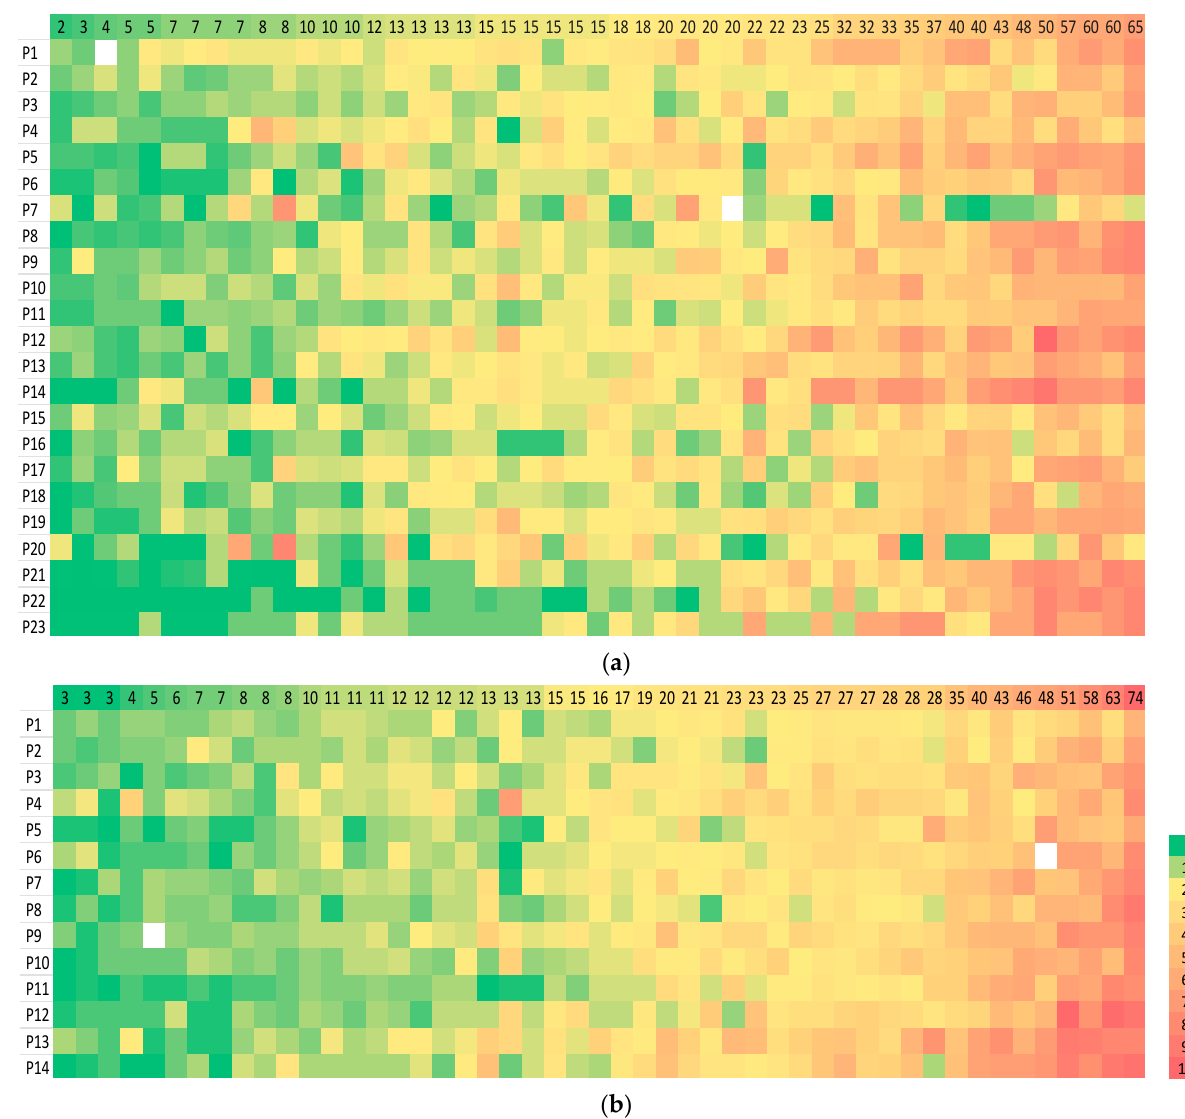
Figure 2. Heatmap of sTILs scores given by pathologists for 49 TNBC cases. A visual representation of sTILs scores in which each row represents a pathologist (numbered as in Figure 1) and each column a case for ( a ) Circulation 1 and ( b ) Circulation 2. The colour of each cell represents the sTILs score for the case, increasing from low (green) to high (orange), as denoted in the separate vertical key; missing data are white. The value given in each cell in the top row of each heat map is the median sTILs score for that case in the respective circulation, and the cases are ordered left to right from the lowest to the highest median sTILs score. Outlier scores for a case relative to others appear as mismatches of colour e.g., green cells within a zone of orange. There is more heterogeneity of scores in circulation 1 compared to circulation 2 and the scores given by pathologists 7 and 20 in circulation 1 diverge considerably from others, whereas the scores given by pathologist 7 in circulation 2 align with those of other pathologists. In circulation 2, the scoring pattern of pathologists 4 and 13 appear to diverge from that of others.